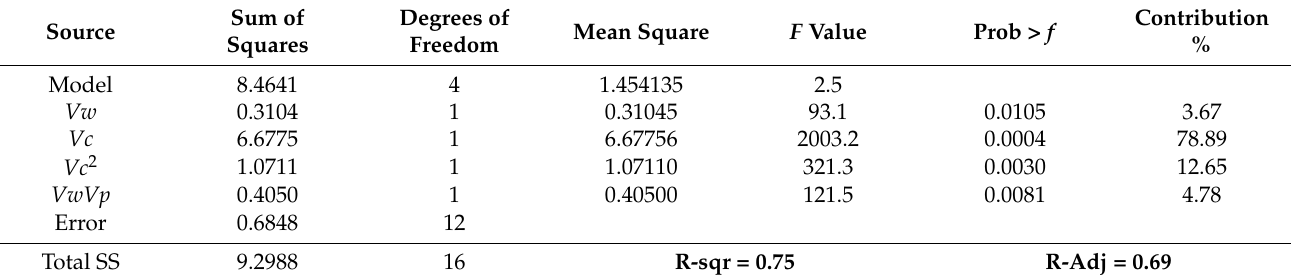
Table 9. ANOVA table for Sa (after elimination) for a multigranular